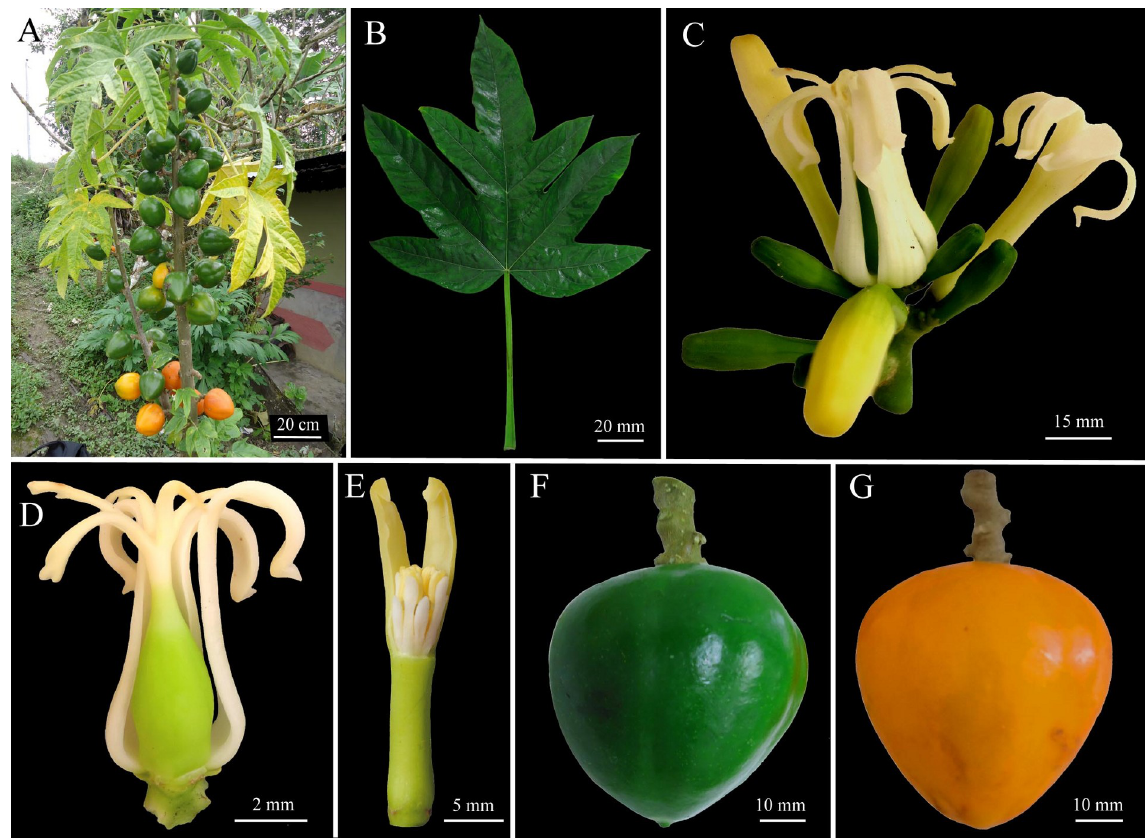
Fig 7. Morphology of Vasconcellea peruviensis (CHAX245). A, Habit. B, Palmately compound leaf. C, Female inflorescence. D, Pistillate flower. E, Staminate flower. F, Immature fruit. G, Mature